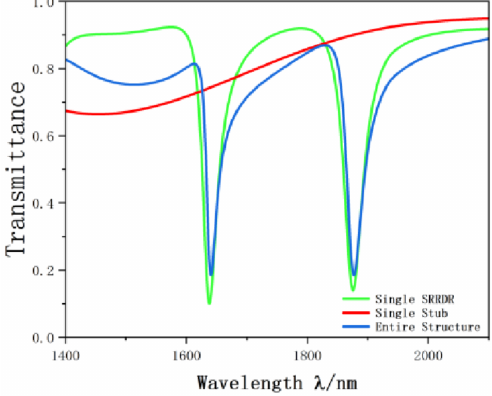
Figure 4. Single stub.